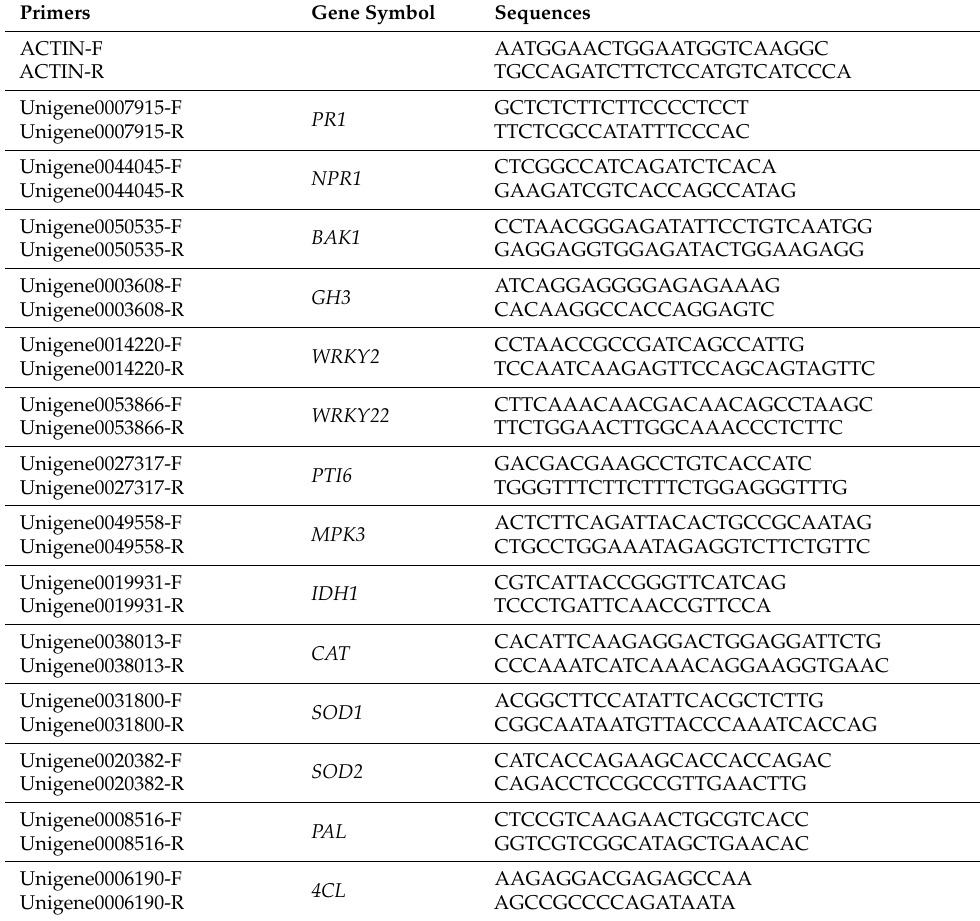
Table 1. Primers used in the qRT-PCR